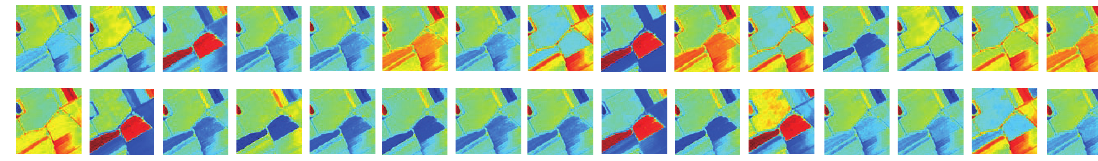
Figure 4. The intermediate results of 30 hidden nodes in visual by the SCAAE.